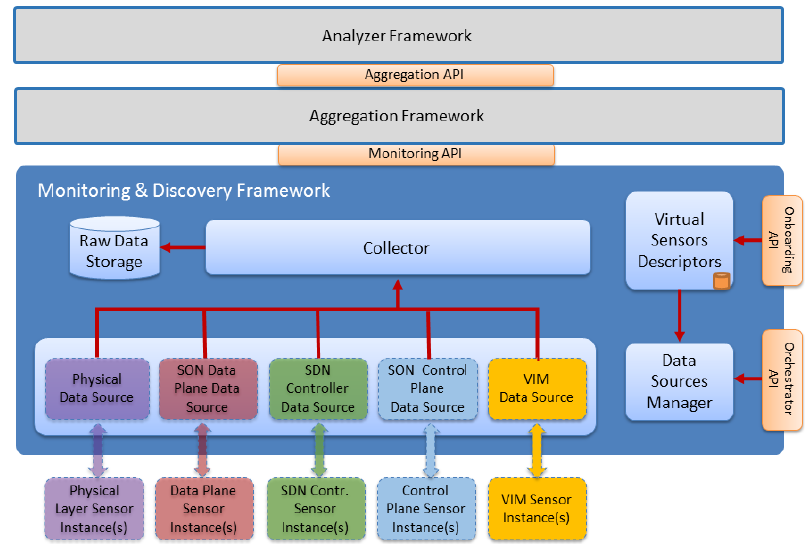
Figure 6. Monitoring and Discovery Framework Architecture.